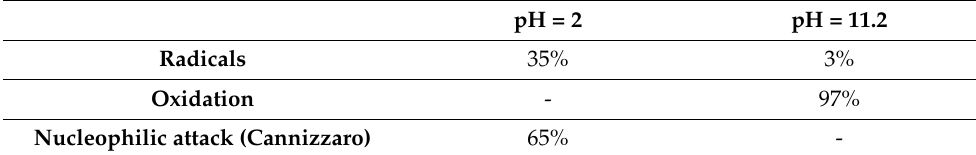
Table 4. Percentage of mechanism routes.